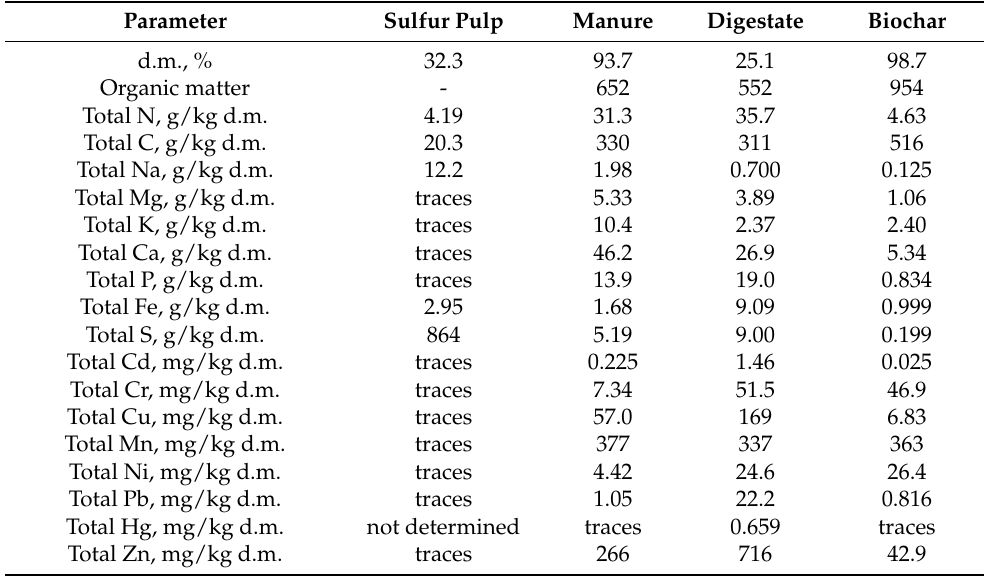
Table 2. Selected chemical properties of materials used in the incubation